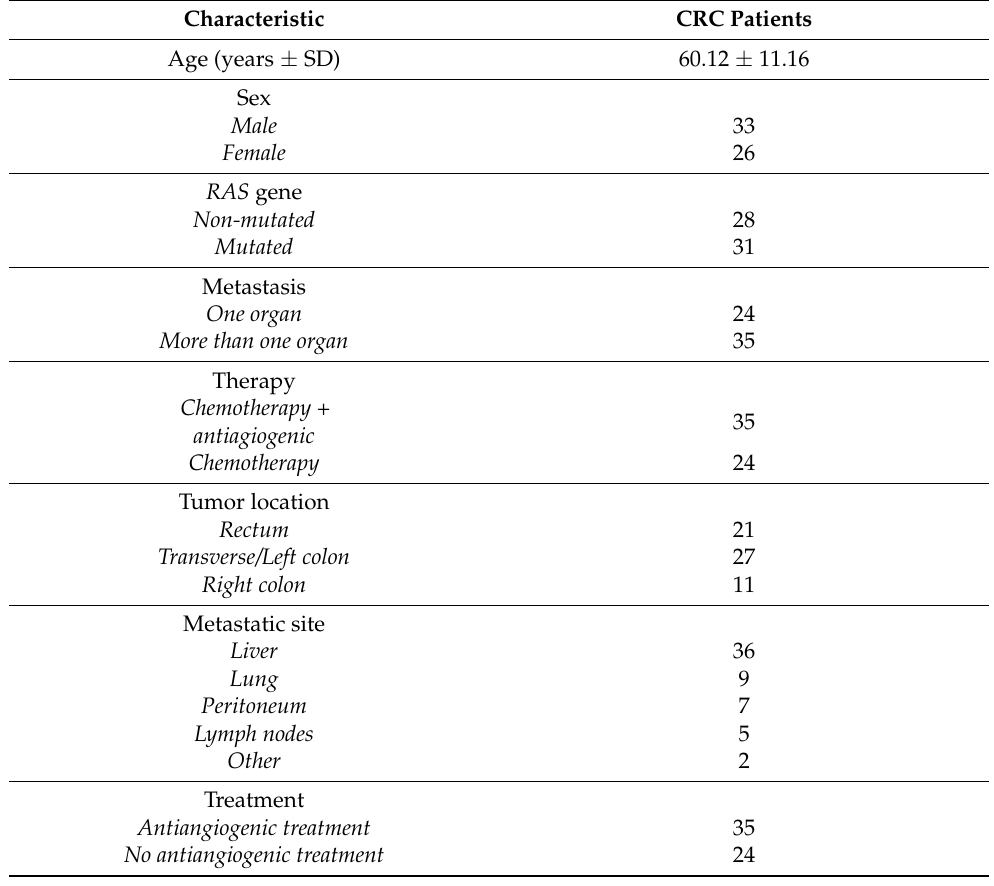
Table 1. Characteristics of metastatic CRC